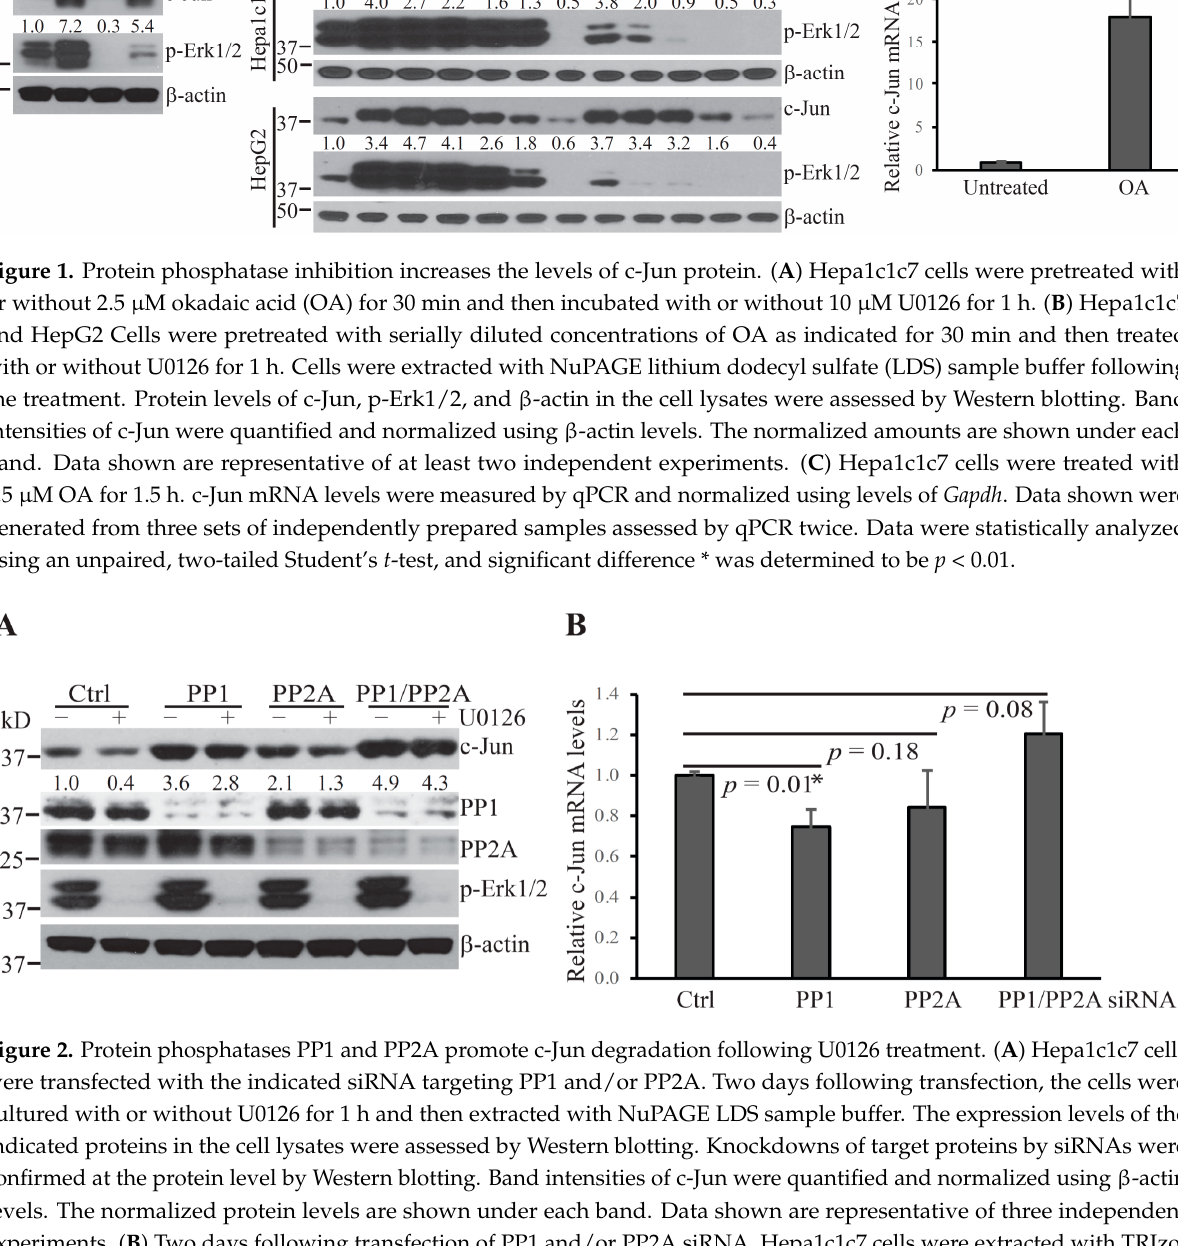
Figure 1. Protein phosphatase inhibition increases the levels of c-Jun protein. ( A ) Hepa1c1c7 c ells were pretreated with or without 2.5 µM okadaic acid (OA) for 30 min and then incubated with or without 10 µM U0126 for 1 h. ( B ) Hepa1c1c7 and HepG2 Cells were pretreated with serially diluted concentrations of OA as indicated for 30 min and then treated with or without U0126 for 1 h. Cells were extracted with NuPAGE lithium dodecyl sulfate (LDS) sample buffer following the treatment. Protein levels of c-Jun, p-Erk1/2, and β -actin in the cell lysates were assessed by Western blotting. Band inten- sities of c-Jun were quantified and normalized using β -actin levels. The normalized amounts are shown under each band. Data shown are representative of at least two independent experiments. ( C ) Hepa1c1c7 cells were treated with 2.5 µM OA for 1.5 h. c-Jun mRNA levels were measured by qPCR and normalized using levels of Gapdh . Data shown were generated from three sets of independently prepared samples assessed by qPCR twice. Data were statistically analyzed using an unpaired, two-tailed Student’s t -test, and significant difference * was determined to be p < 0.01.